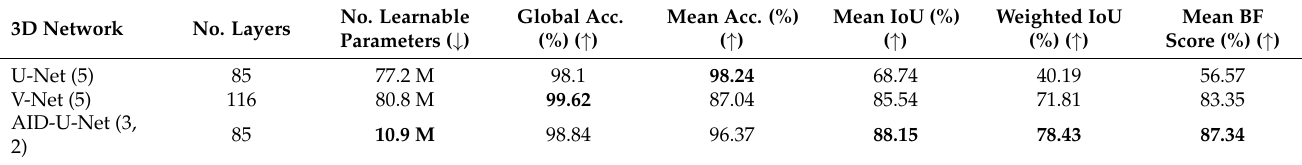
Table 9. Comparative results between semantic segmentation of 3D brain tumors achieved by 3D U-Net, V-Net and proposed AID-U-Net (3,